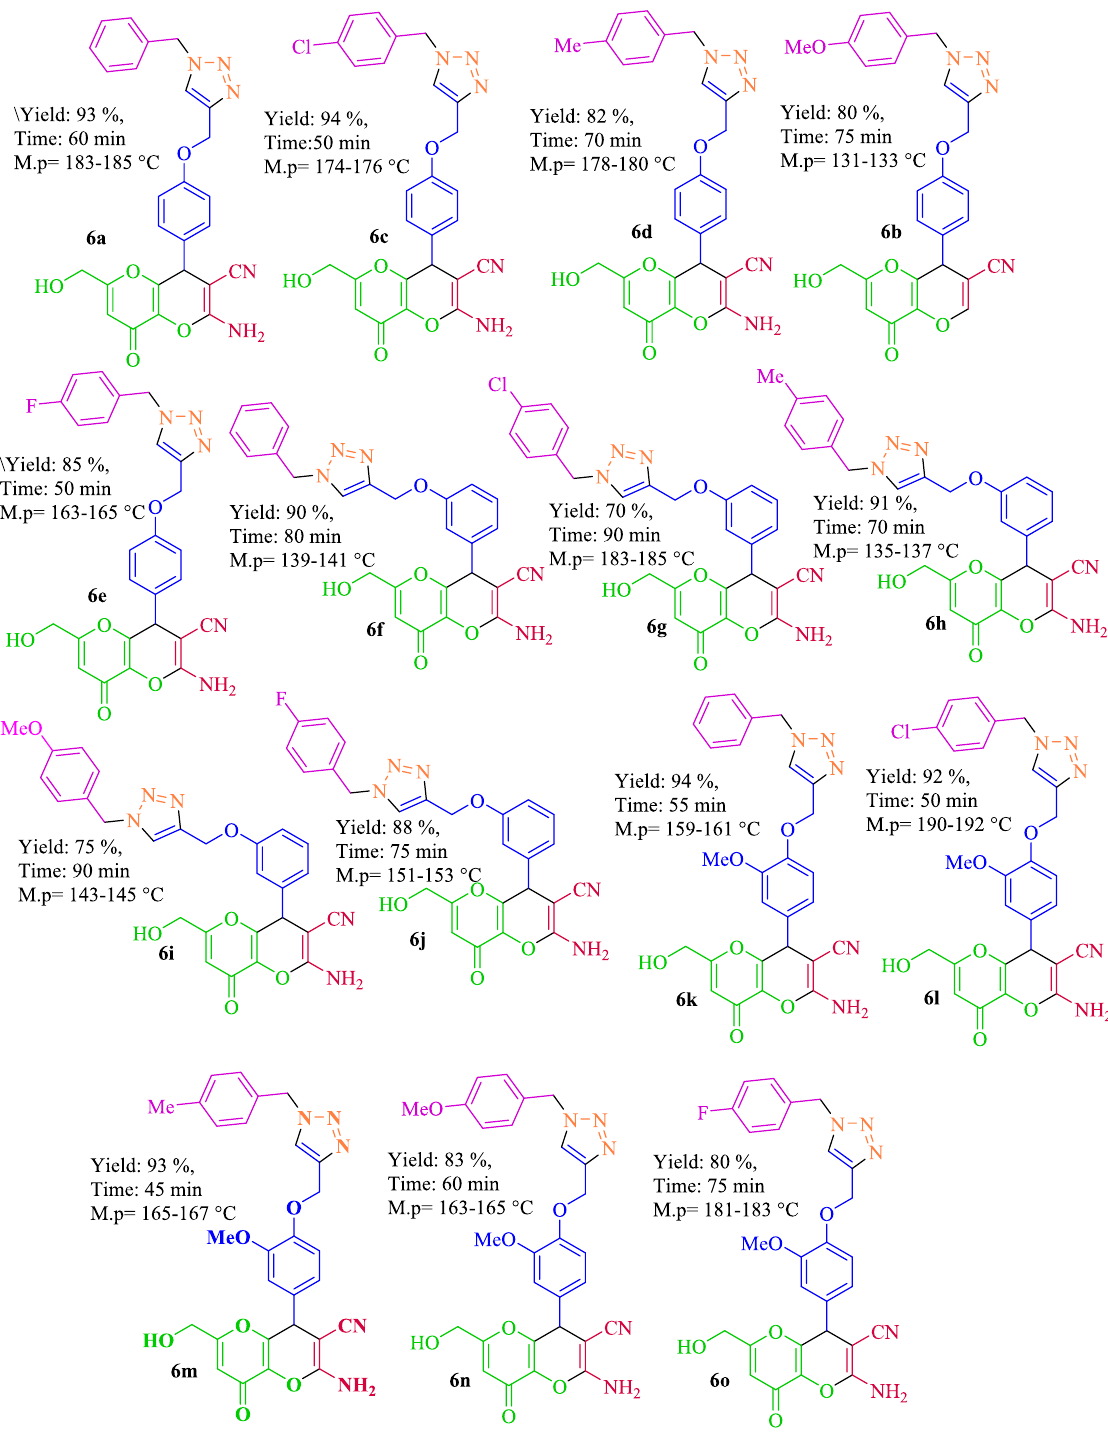
Figure 13. Synthesis of triazole-dihydropyrano[3,2- b ]pyran using Fe 3 O 4